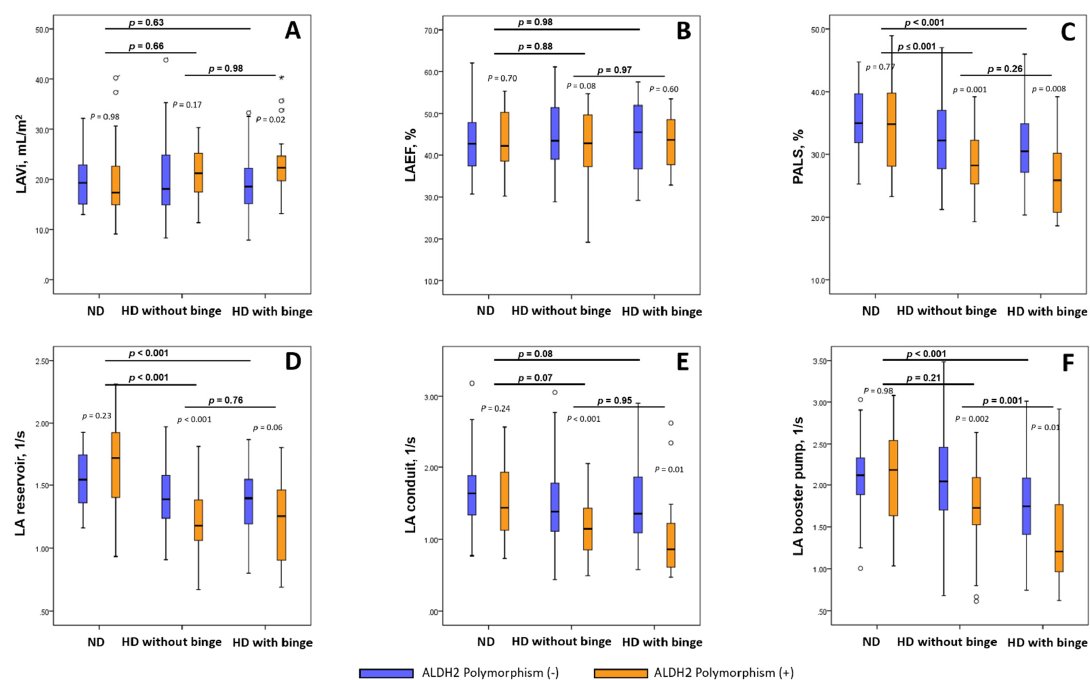
Figure 3. Comparisons of novel LA mechanical parameters with regard to the presence of ALDH2 polymorphism in subgroups stratified across non-drinkers (n = 56) and habitual drinkers presenting without (n = 132) and with (n = 61) binge-drinking behavior. Comparisons of worsened LA mechanical parameters (including LAVi ( A ), LAEF ( B ) and nov-el LA deformation markers ( C – F ) between ALDH2 polymorphism ( − ) and (+) two groups within any subcategory. * refers to statistical significance ( p < 0.05) between ALDH2 polymorphism ( − ) and (+).